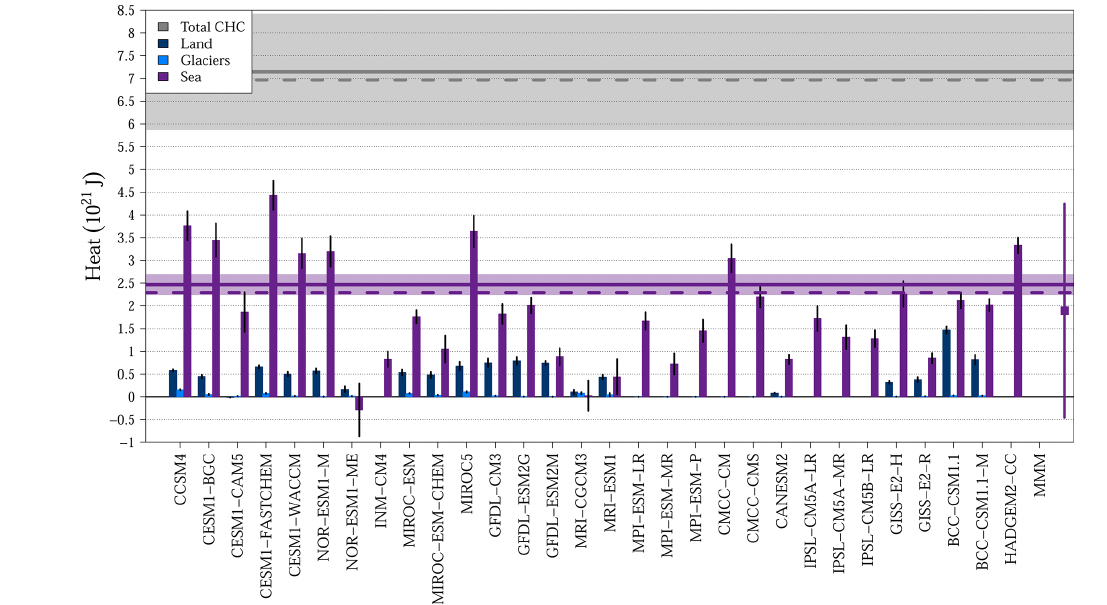
Figure 3. Simulated CHC for 1972–2005CE. Dark blue bars indicate the heat uptake due to changes in subsurface ice mass, blue bars indicate the heat uptake due to changes in glacier mass, and purple bars indicate the heat uptake due to changes in sea ice volume (see Sect. 2 for details). Vertical black lines at the top of the bars indicate the 95% confidence interval for each model. The multimodel mean and 95% confidence interval for the heat uptake due to changes in sea ice volume are indicated in the right side of the panel (MMM). Observations from von Schuckmann et al. (2020) are shown as solid horizontal lines and shadows (means and 95% confidence intervals), and observations from Church et al. (2011) are displayed as dashed horizontal